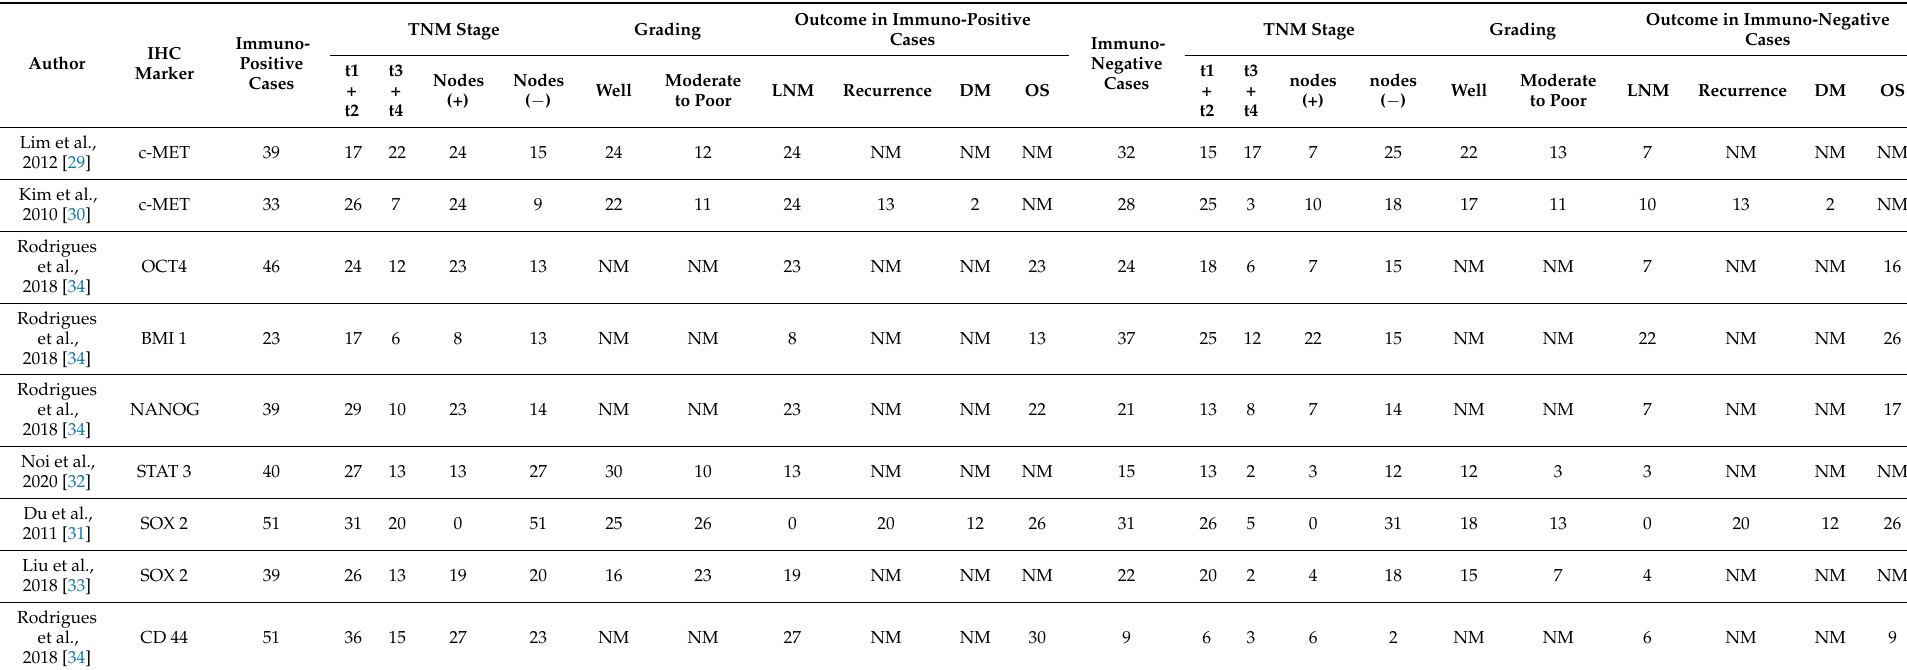
Table 2. Study characteristics: expression of cancer stem cells markers vs. clinicopathological features and